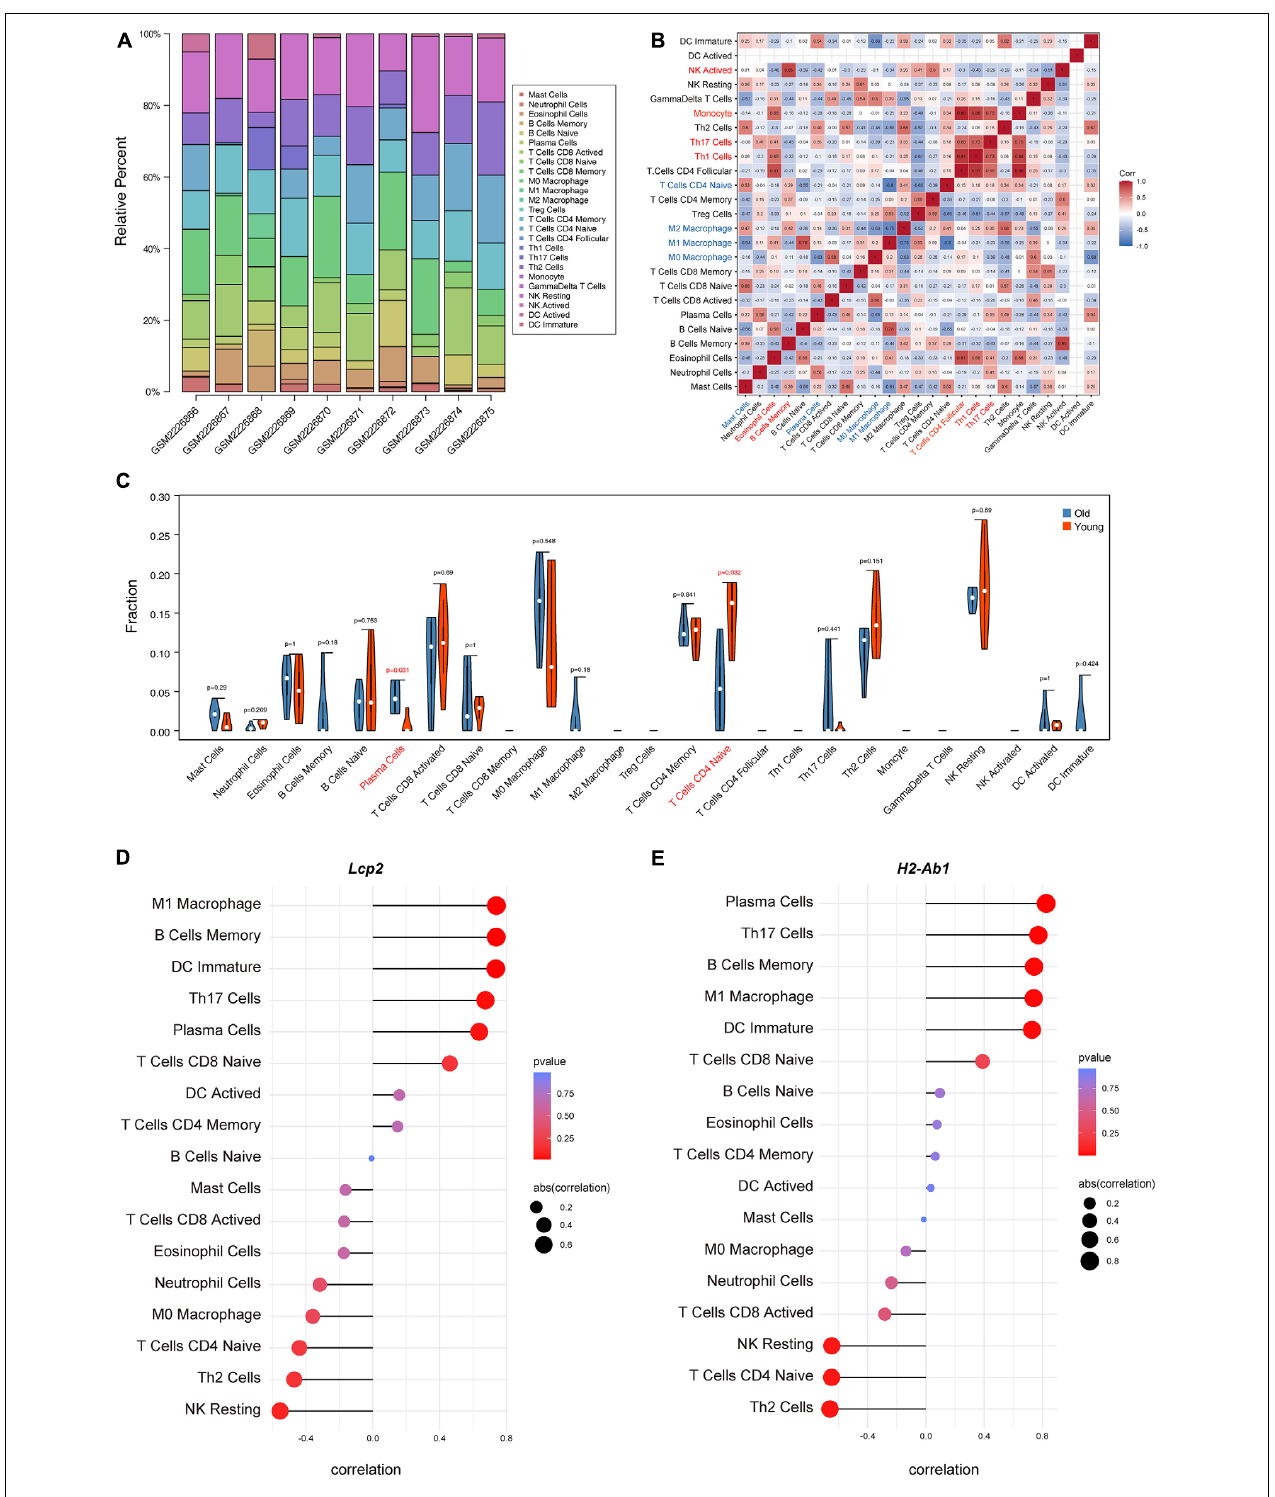
FIGURE 5 | Immune cell infiltration evaluation and correlation analysis. The composition of 25 immune cell types in each sample (A) . Correlation heatmap of the immune cell types (B) ; the intensity of the color indicated the strength of the correlation; red represents a positive correlation, while blue represents a negative correlation; violin plot of the proportion of various immune cell types (C) ; p value < 0.05 was marked red. Correlation between Lcp2 and infiltrating immune cells (D) . Correlation between H2-Ab1 and infiltrating immune cells (E) .